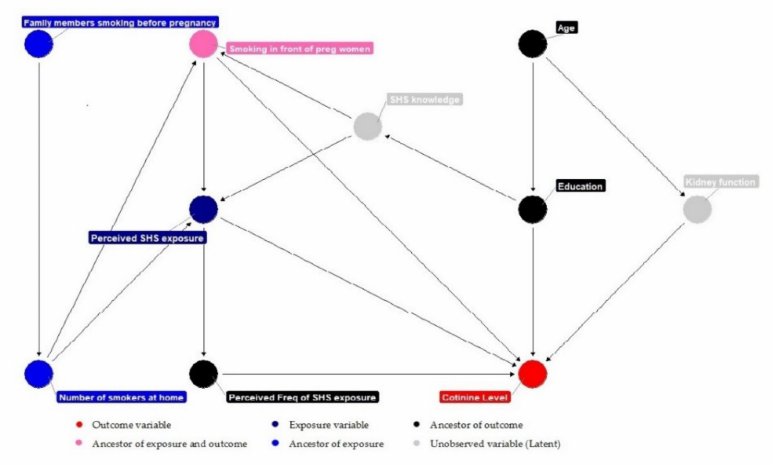
Figure 1. Directed acyclic graph representing the causal assumptions used for covariate